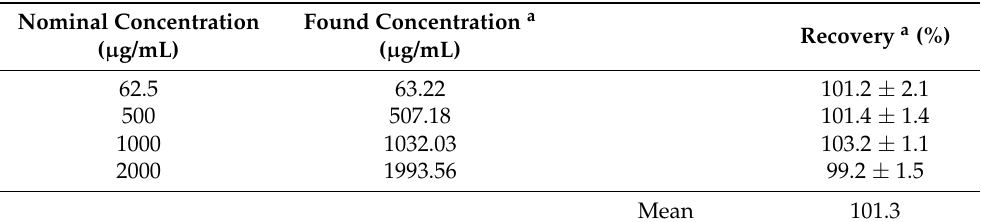
Table 6. Analysis of lorbrena ® tablets by the proposed MW-SPA. Nominal Concentration Found Concentration ( µ g/mL)